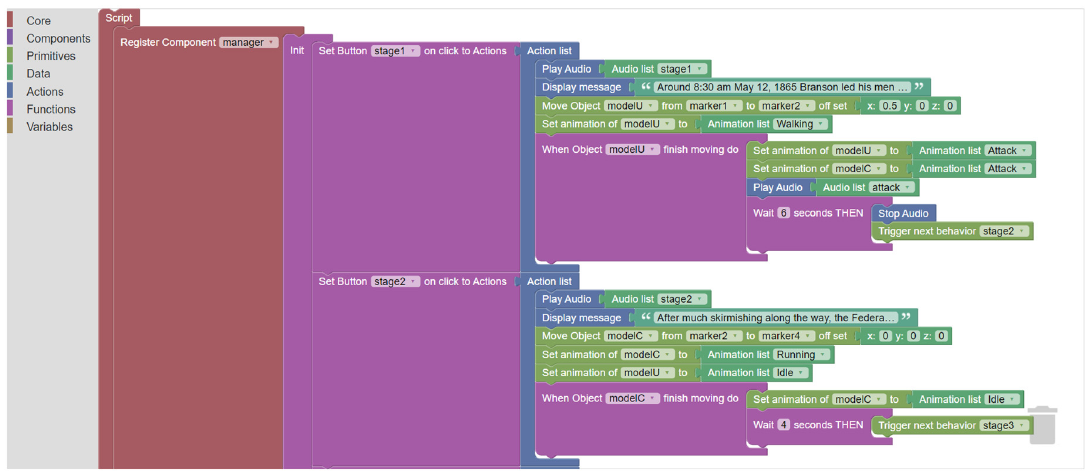
Figure 7. Use case of using BlocklyAR to recreate the Palmito Battle Ranch